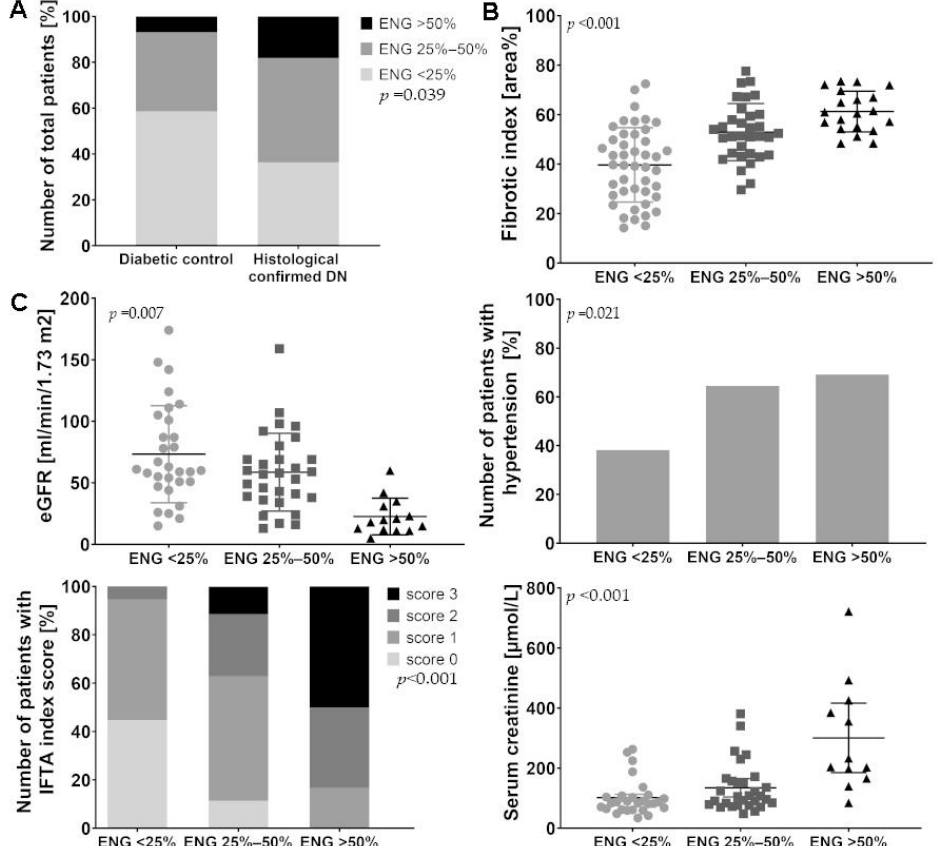
Figure 1. Characterization of the endoglin-positive interstitial area in an autopsy cohort, and correlation with renal damage. ( A , B ) Autopsy samples from 55 patients with diabetic nephropathy (DN) and 25 diabetic controls without DN were stained using an endoglin antibody and Sirius Red (to measure interstitial fibrosis). ( A ) Endoglin staining was scored semi-quantitatively, and patients were classified based on their scores. The group with DN had significantly more interstitial endoglin (ENG) compared to the diabetic control group ( p < 0.05). ( B ) High endoglin levels in the 55 patients with DN were correlated with a higher interstitial fibrosis index ( p < 0.001). ( C ) High endoglin levels in the interstitium of DN patients were correlated with decreased eGFR ( p < 0.01), the presence of hypertension ( p < 0.05), a higher IFTA index score ( p < 0.001), and increased serum creatinine levels ( p < 0.001). Data were analyzed using a Chi-square test for trend (linear data compared with ordinal data) or Spearman’s rank correlation (categorical/ordinal data compared with ordinal data). IFTA, interstitial fibrosis, and tubular atrophy.